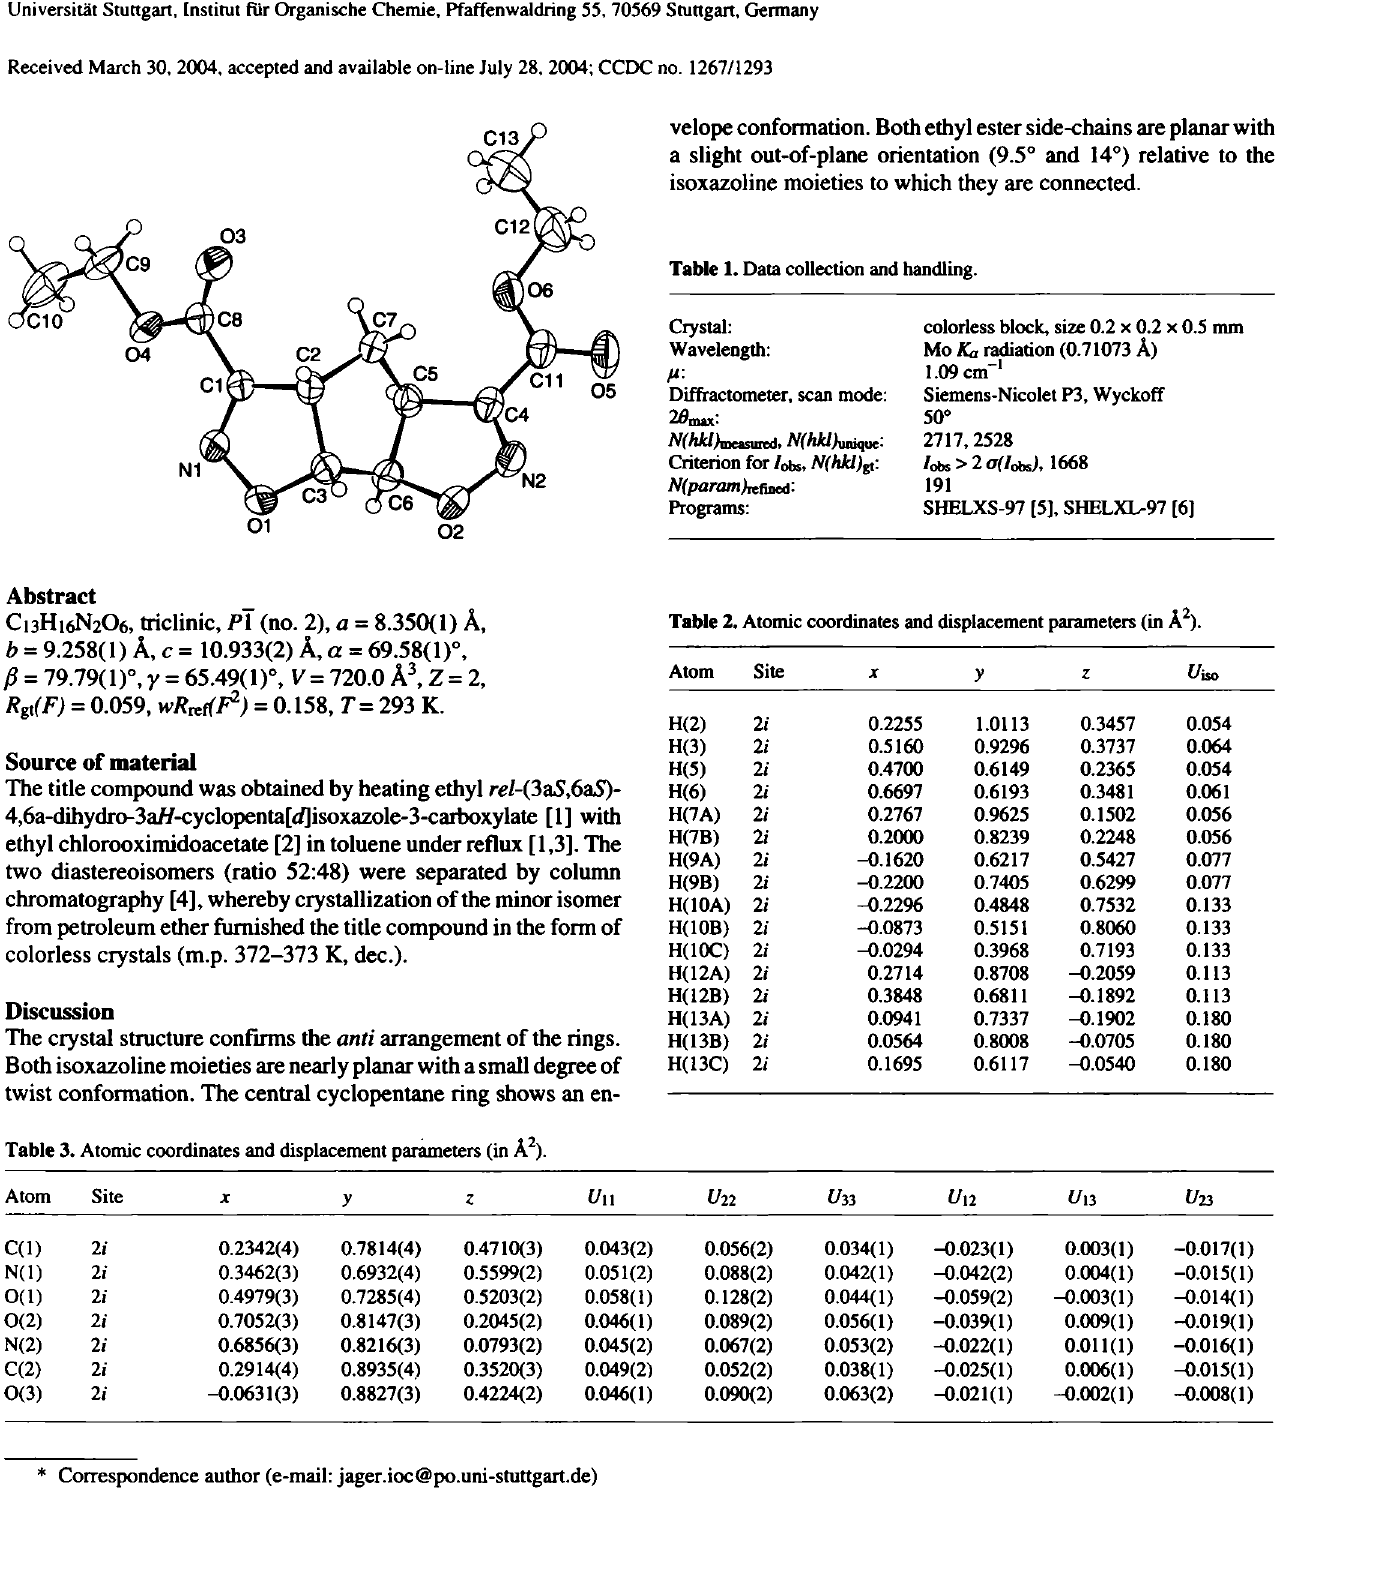
Table 1. Data collection and handling.